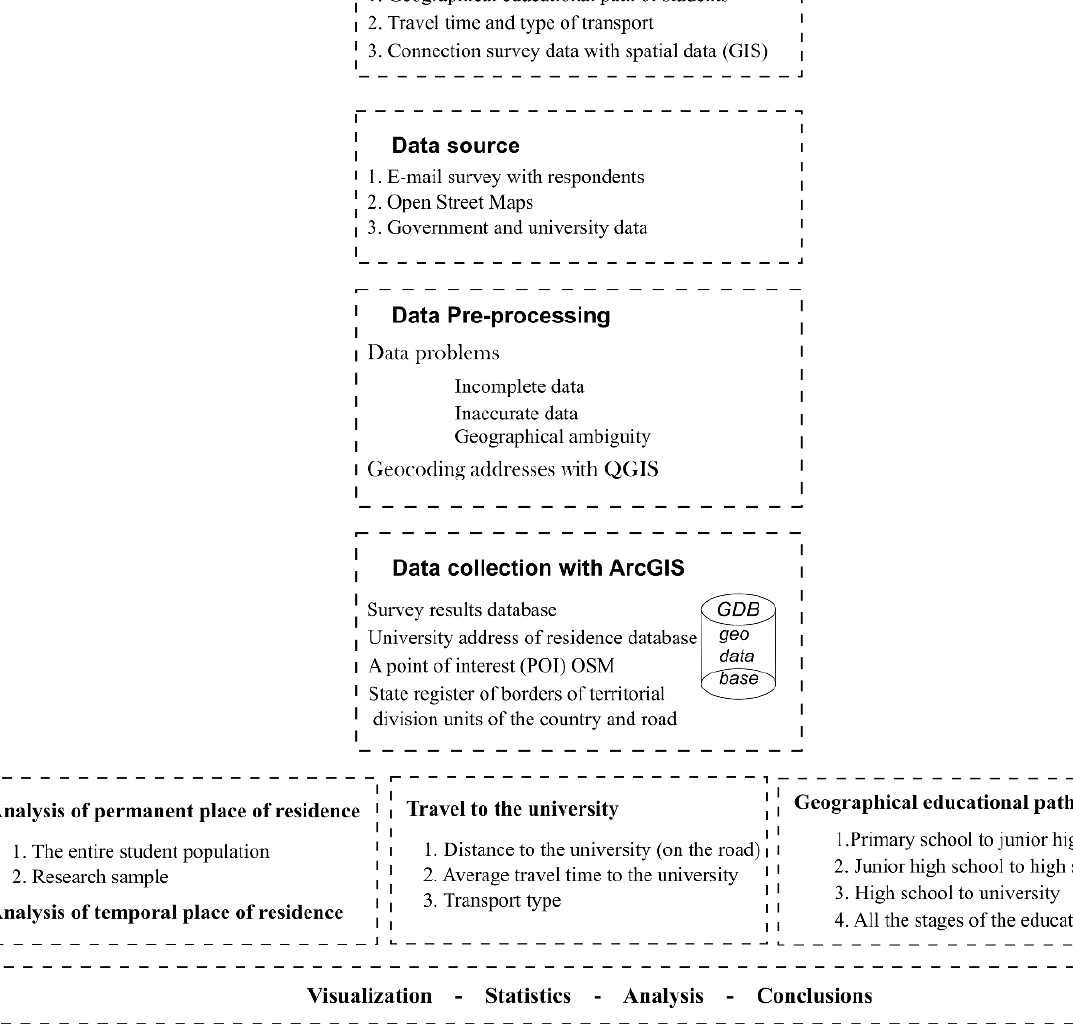
Figure 1. Methodology for geographical study of educational path.